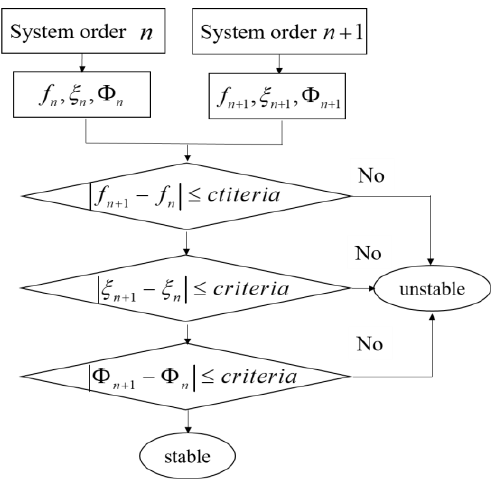
Figure 4. Flowchart of the stability diagram method.